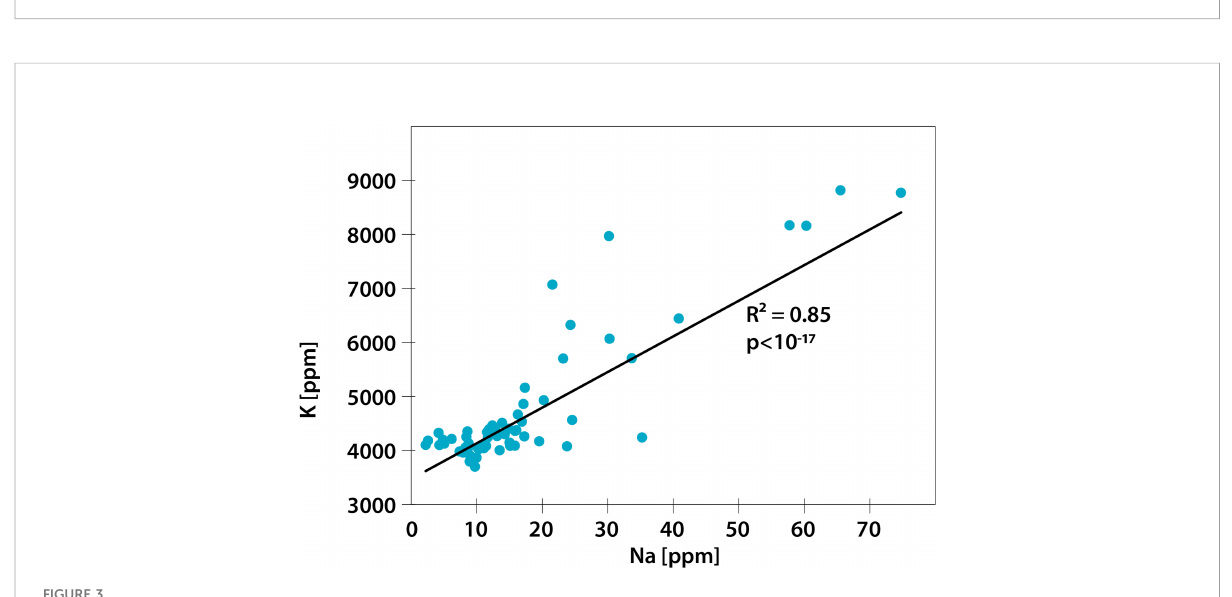
FIGURE 3 Correlation between Na and K concentrations in the studied pollen. N=61.